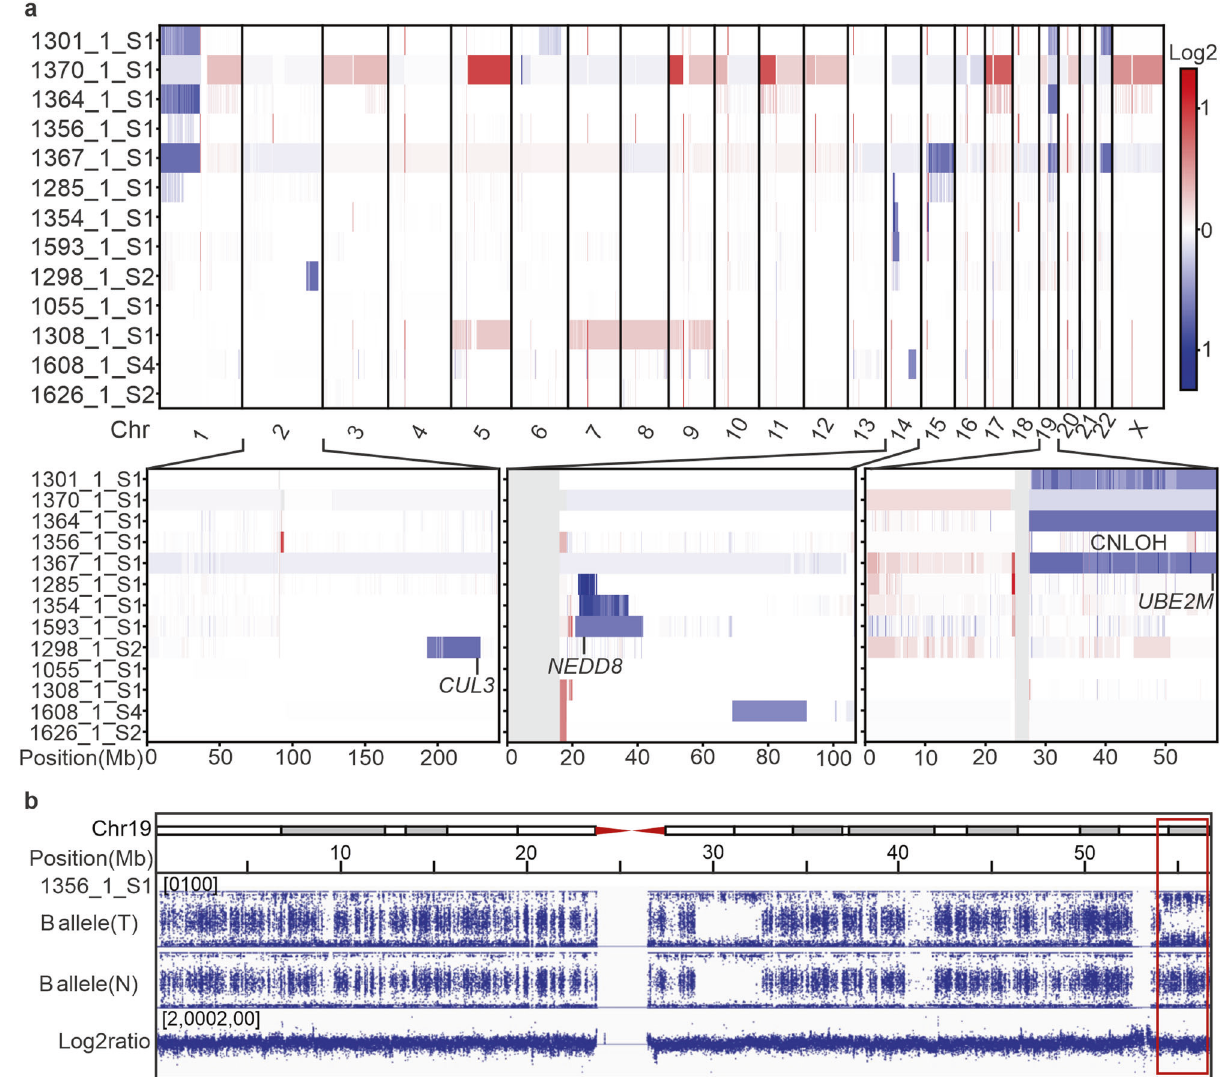
Fig. 2 Somatic copy number alterations in AKR1B10hi leiomyomas. a AKR1B10hi leiomyomas displayed relatively stable chromosomal pro fi les. Recurrent loss of the 19q-arm was seen in four AKR1B10hi leiomyomas and three of these deletions overlapped with a gene-level mutation in UBE2M . An interstitial 14q deletion was seen in three leiomyomas and two of these deletions overlapped with a gene-level mutation in NEDD8 . Only one sample harbored a 2q deletion, and this deletion overlapped with a gene-level mutation in CUL3 . b One sample with a gene-level mutation in UBE2M displayed copy-neutral loss of heterozygosity (CN-LOH) at the terminal q-arm of chromosome